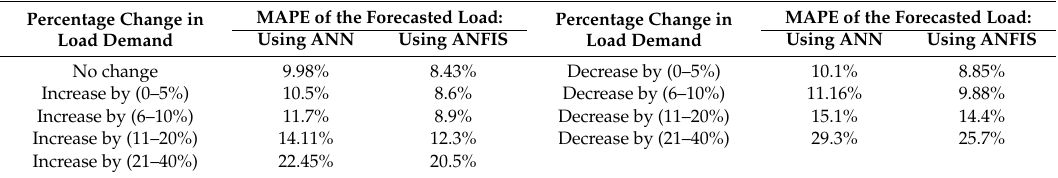
Table2. ComparisonbetweenusingANFISversusANNinSTLFforasmallMGandtheresultantMAPE. MAPE of the Forecasted Load: MAPE of the Forecasted Load: Percentage Change in Percentage Change in Using ANN Using ANFIS Using ANN Using ANFIS Load Demand Load Demand No change 9.98% 8.43% Decrease by (0–5%) 10.1% 8.85% Increase by